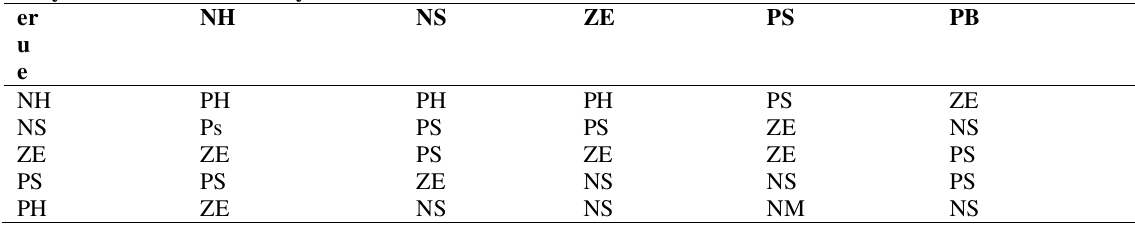
Fuzzy inference rules of the system control.